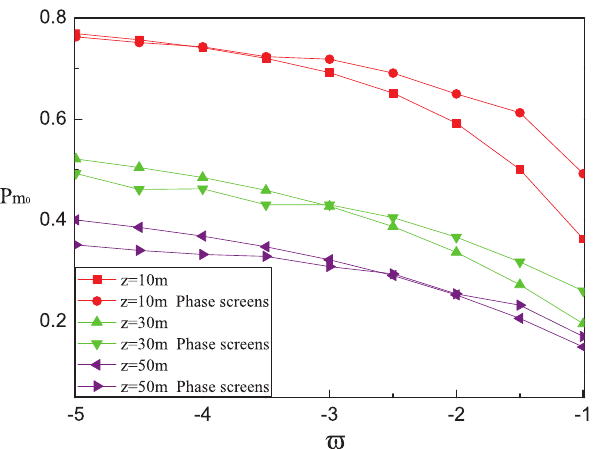
Figure 3. Detection probability P m of the HyGG vortex beam as a function of the temperature-salinity 0 contribution ratio (cid:118) when the transmission distance z is 10 m, 30 m and 50 m.